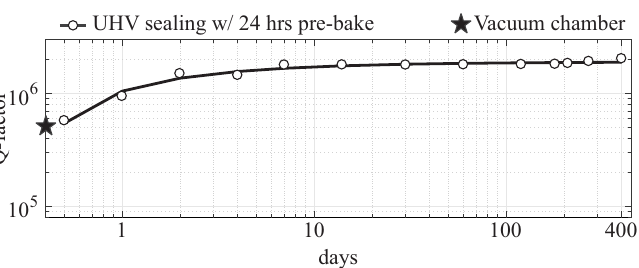
Figure 8. The Q-factor measurements over a long period of time revealed vacuum stability inside a sealed cavity after vacuum sealing (DUT3). The improvement of the Q-factor is related to the pumping of residual gas molecules by the activated getter [37].